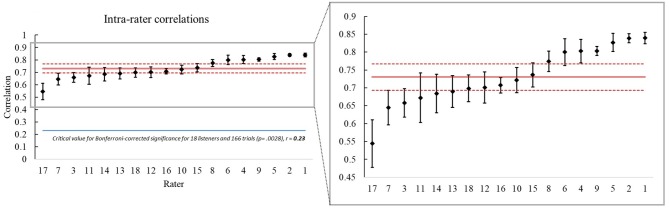
Mean intra-rater correlations organized from lowest (r = 0.54) to highest (r = 0.84) for all 18 listeners, with an average correlation of 0.73 indicated by the solid red line with a 95% CI of 0.69 −0.77 represented by dotted red lines. Intra-rater correlations were calculated for each of the 18 listeners by averaging the correlations of their ratings across all possible pairings of the five trial blocks for each of the listeners. The left-right distinction is as in Figure 1. Again, on the left there is a huge gap between the critical value correlation (blue line) and the actual correlations across the 18 listeners, making clear that all the intra-rater correlations were highly significant (p < 0.00001). Again, the blowup on the right makes it possible to easily examine differences among the 18 listeners in their levels of agreement with their own ratings across the 5 trial blocks, i.e., their rating consistency.